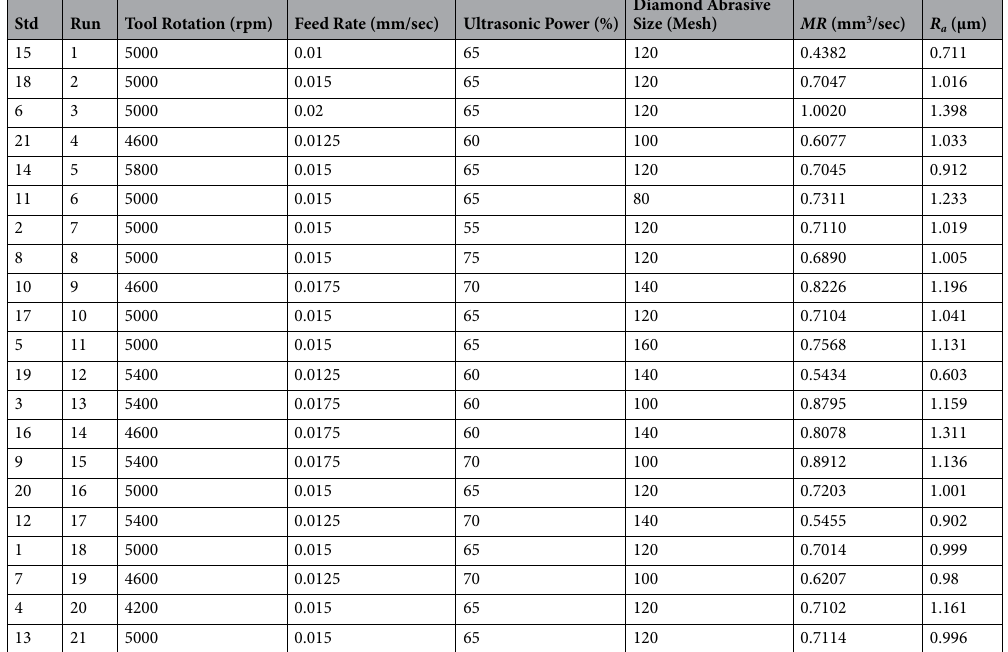
Table 4. Design Matrix and their results.